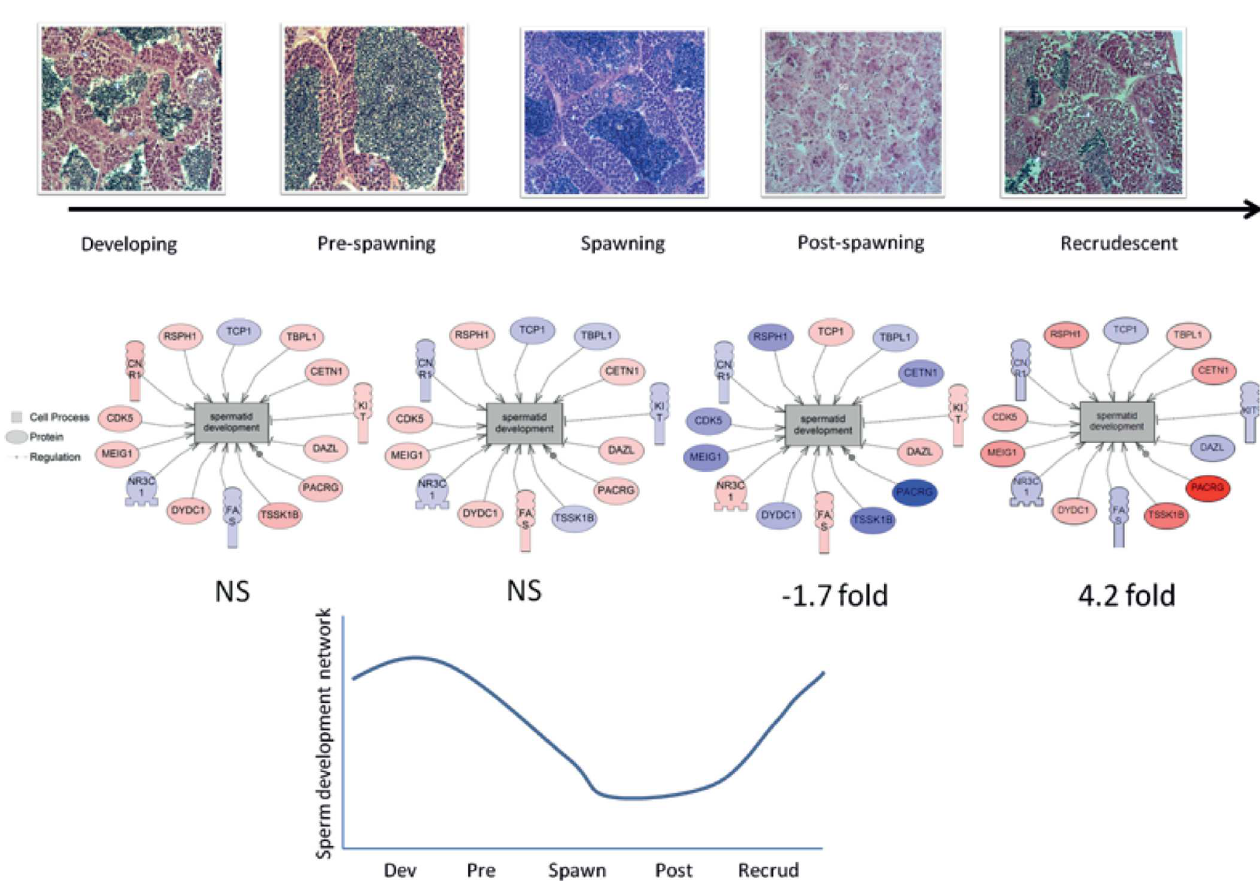
Fig 2. Testis structure from male rainbow darter during the periods designated as “developing, pre-spawning, spawning, post- spawning and recrudescence”. A. Cells are labeledas SG (spermatogonia), SC (spermatocytes), or ST (spermatozoa); the arrow represents 20 μ m. B. Sub-network enrichmentanalysisof a spermatidexpressionnetwork over testis development and a graph belowrepresentingthe expressionnetwork over time based on fold changes of reproductivestage prior to the next acts as the relative comparison(i.e. from developingto pre-spawn, from pre-spawn to spawn, from spawn to post-spawn and from post-spawn to recrudescent). Blue colors represent a down-regulated gene and red colored figures represent an up-regulated gene. The curve represent the overall relativelyabundanceof the genes involvedon the sperm development network. NS means no